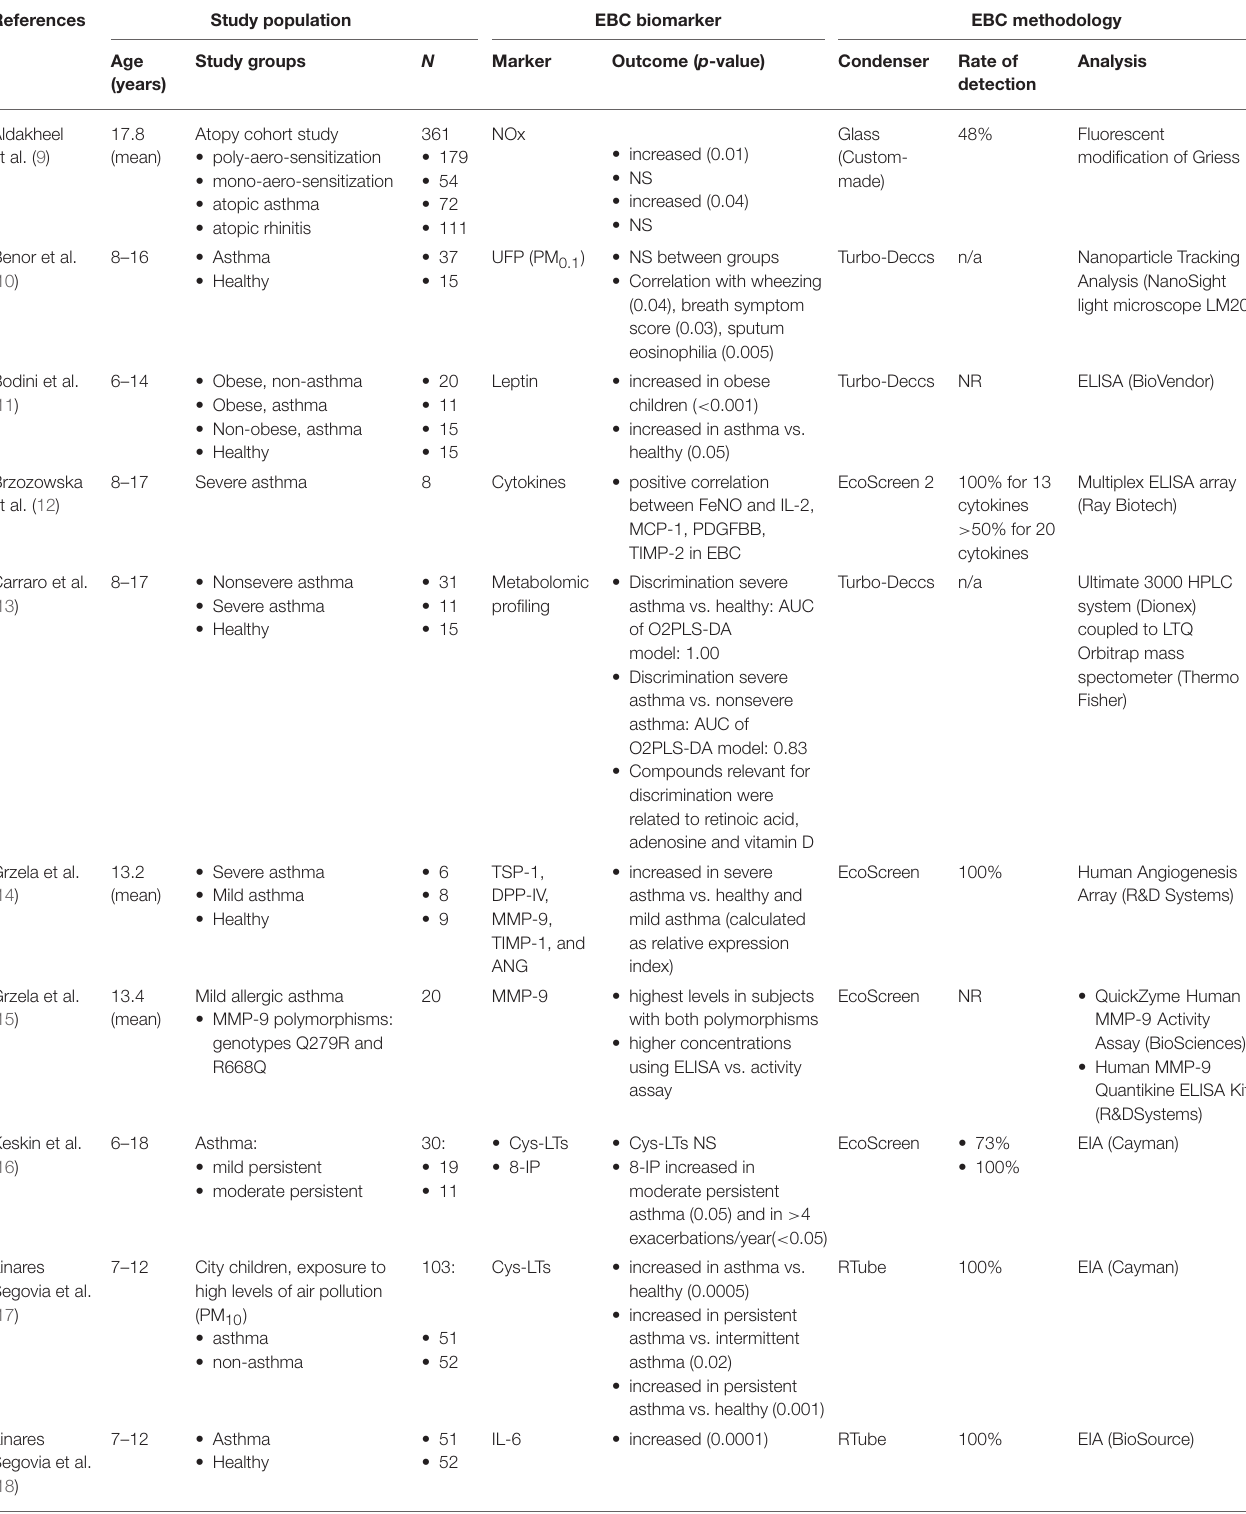
TABLE 1 | Cross sectional studies using EBC in children with